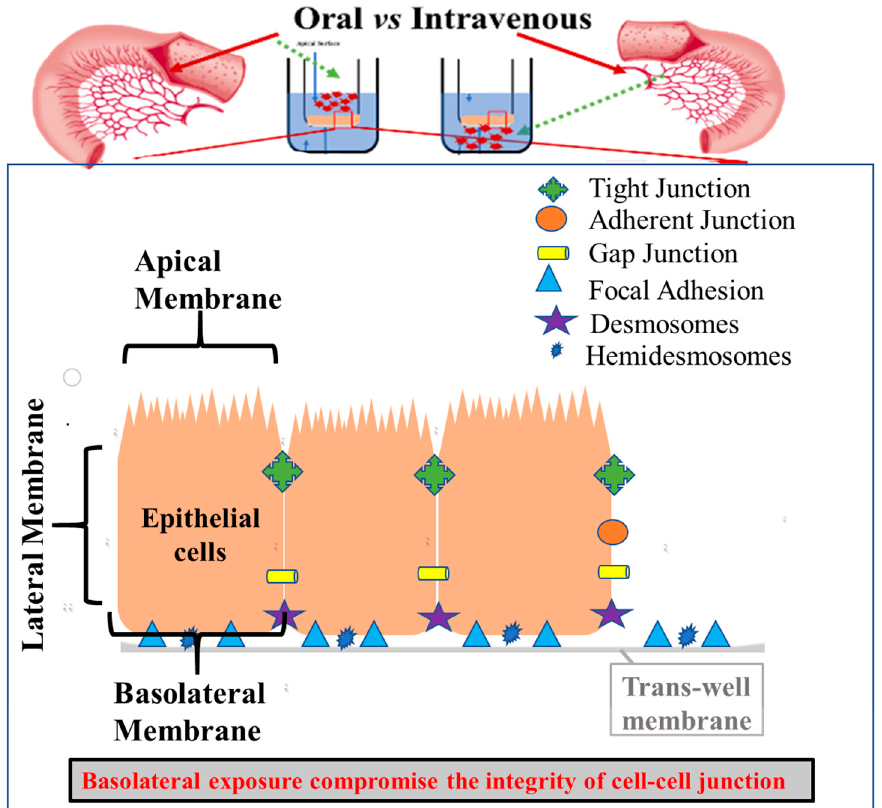
Figure 5. Schematic diagram depicts the detailed structure and exposure routes of the polarized T-84 cells cultured in the trans-well. Exposure of polarized epithelial cells from the apical side mimics oral exposure, whereas exposure from the basal side mimics intravenous exposure. Epithelial cells are attached to each other and with the extracellular matrix by the presence of cell junction proteins. The cell junction proteins hold the cells tight to form a seal from entry of xenobiotics, by forming protein–protein interaction. Paracellular permeability of the intestines is determined by the expression level of these genes. A higher number and larger magnitude of the change in expression of cell junction genes can change intestinal permeability. Here, basolateral exposure resulted in compromised cell–cell junction integrity.